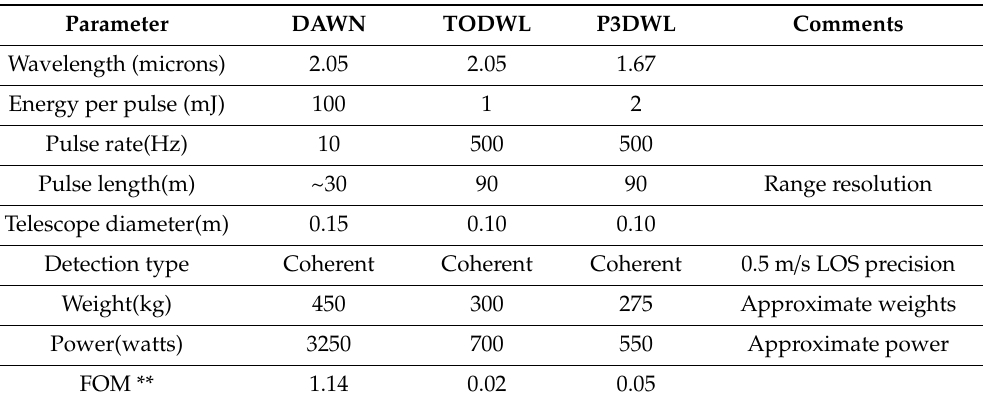
** Figure of Merit (FOM) = Pulse energy × sqrt(pulse rate) × telescope diameter squared × optical e ffi